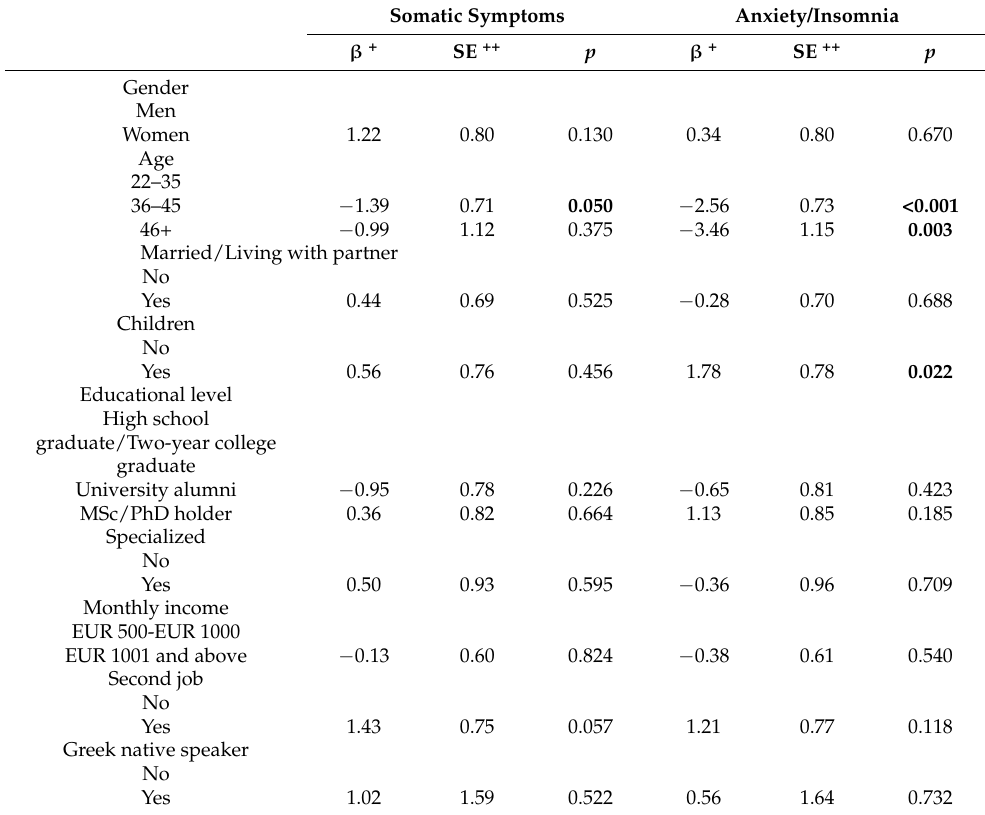
Table 3. Multiple linear regression results with somatic symptoms and anxiety/insomnia